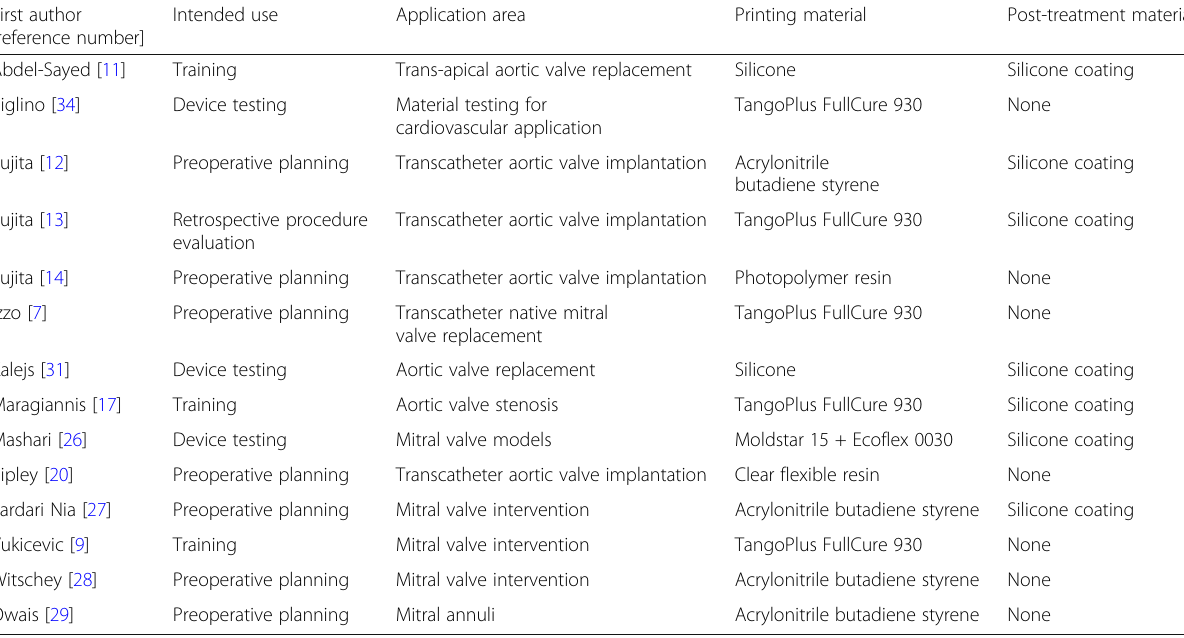
Table 1 3D printing materials for cardiac valve replacement: intended uses and application areas